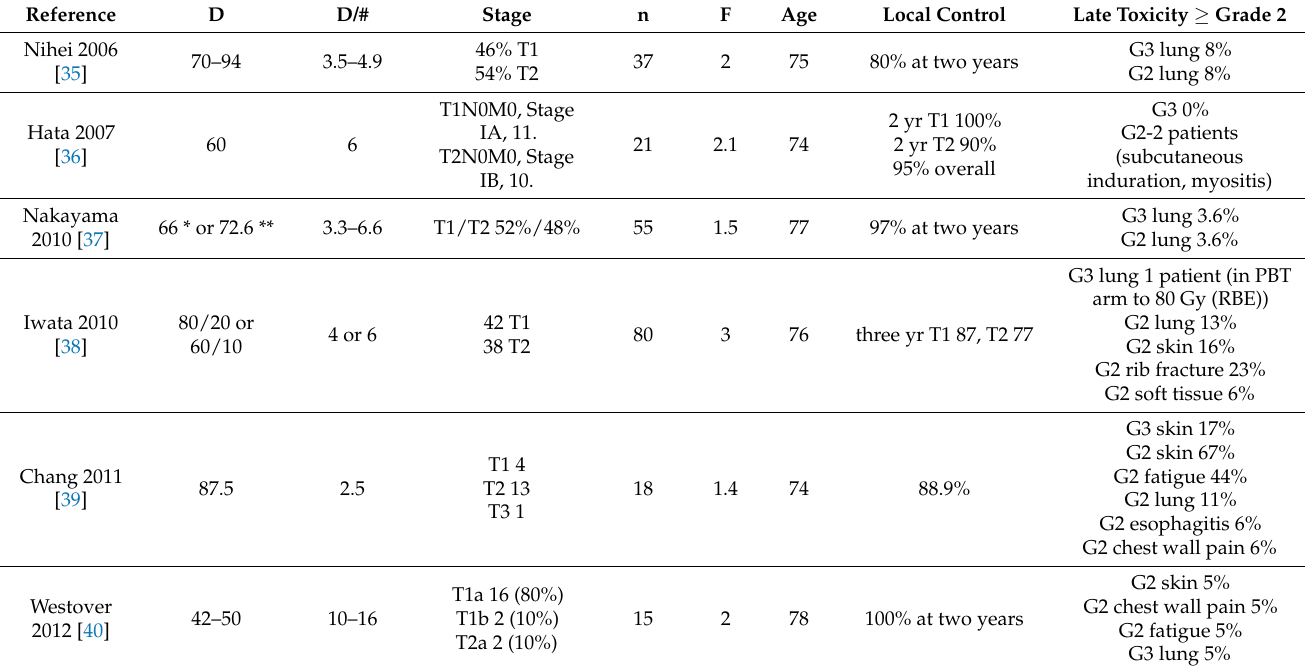
Table 3 summarizes the reported clinical results. Table 3. Lung